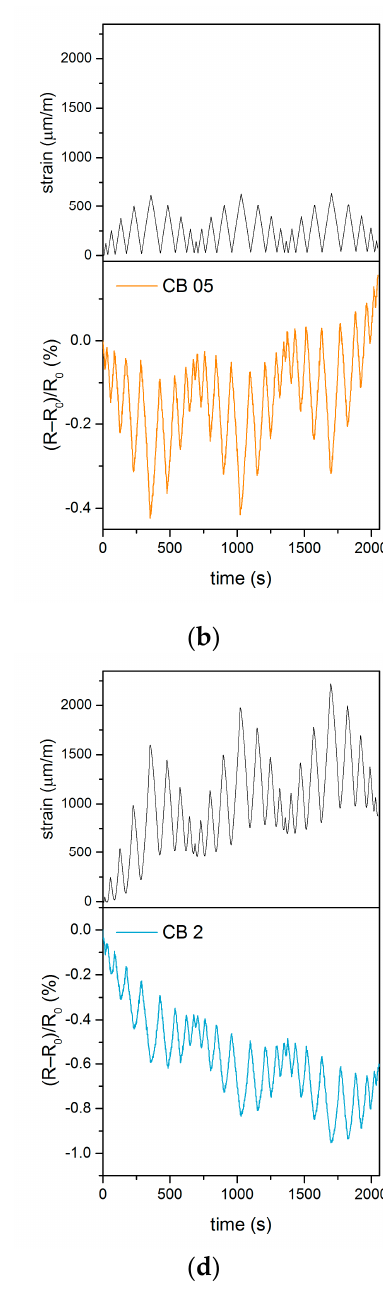
Figure 5. Self-sensing properties during compressive loading with variable amplitude: ( a ) Reference sample; ( b ) sample CB 05; ( c ) sample CB 1; ( d ) sample CB 2.